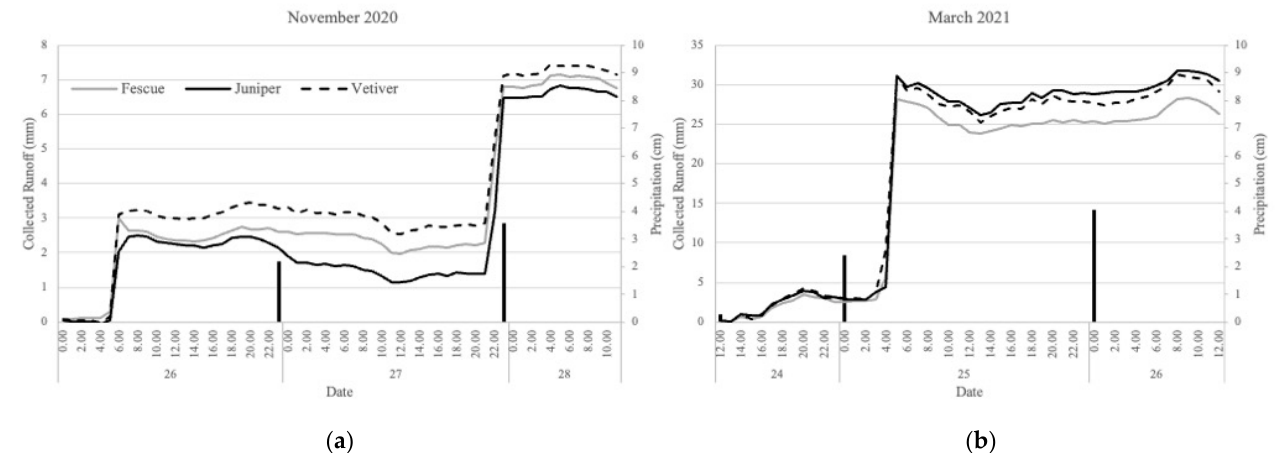
Figure 5. Daily precipitation and hourly change in runoff volume from three erosion plots during rainy periods: ( a ) six months after planting; and ( b ) ten months after planting.